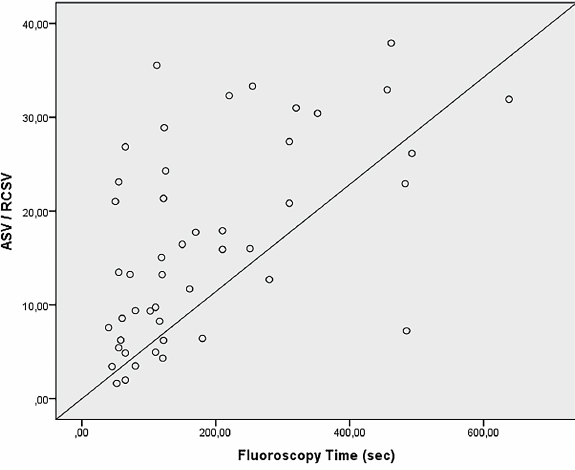
Table 1 - Demographic, preoperative and perioperative features of study cohort.